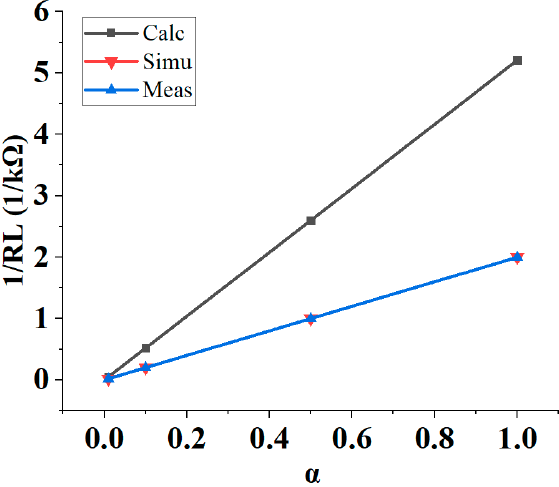
Figure 8. 1/ R L versus α at the same input voltage under the peak rectifying efficiency.